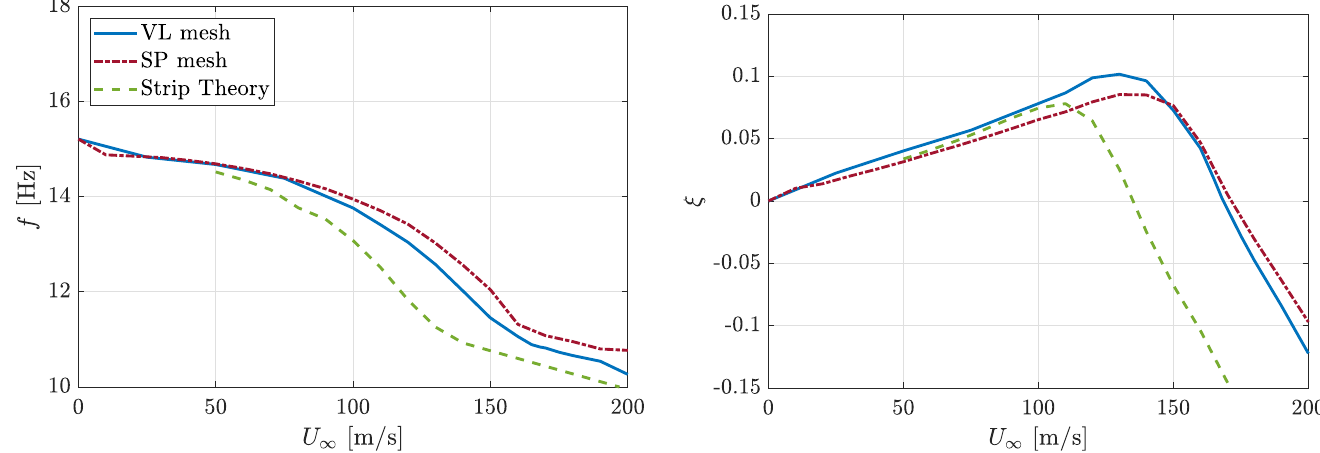
Figure 9. Frequency and damping versus velocity for Goland’s wing. Coupled simulations results (VL and SP mesh) and MBDyn results with 2D Strip Theory